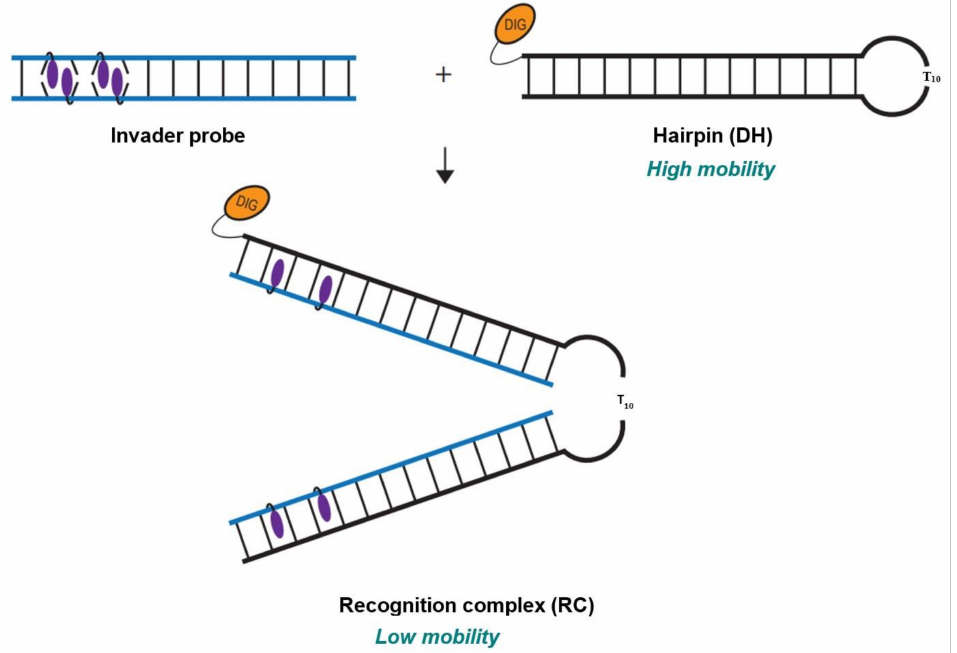
Figure 2. Illustration of EMSA assay used to evaluate dsDNA-recognition of Invader probes. In the initial screen, a 100-fold molar excess of each Invader probe was incubated with the corresponding DNA hairpin target for 15 h at 37 ◦ C in a HEPES buffer contain- ing 100 mM of NaCl and 5 mM of MgCl 2 (Figure 3) [41]. Essentially complete dsDNA- recognition was observed for four of the ten probes ( INV2 , INV7 , INV8 , and INV10 ), while five probes resulted in moderate recognition (40–70%, INV1 , INV3 , INV5 , INV6 , and INV9 ) (Figure 3 and Table 3). No dsDNA recognition was observed for INV4 ; this was a surprising result considering that this probe has been used to detect chromosomal DNA targets under non-denaturing FISH conditions